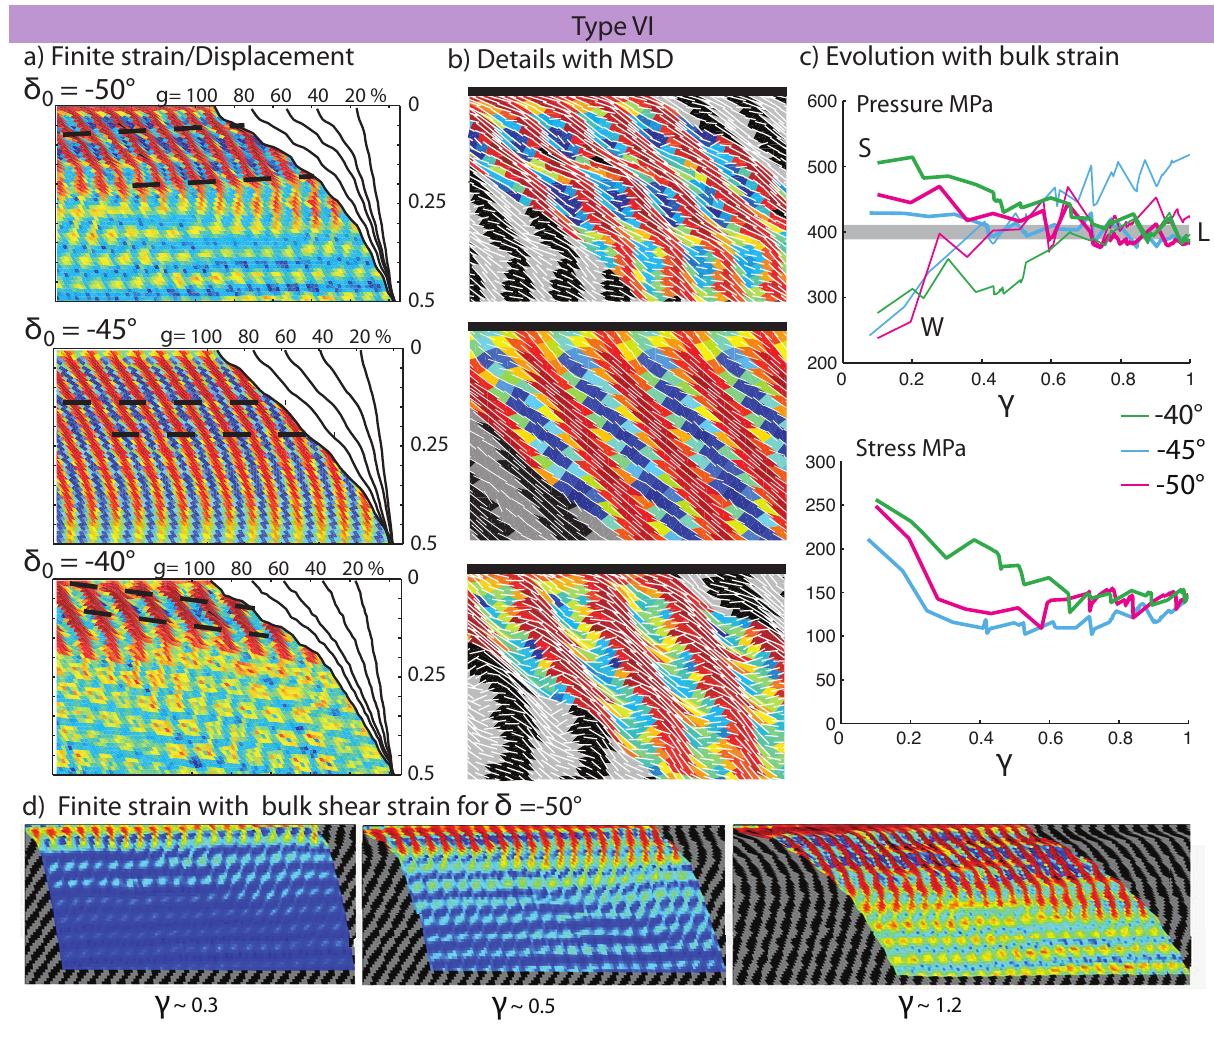
Fig. 7. Type IV (a) Maximum shear strain (red) is located in weak layers. Incipient shear bands orientation is outlined by dashed lines. Depth deformation profiles for γ respectively equal to 0.2, 0.4, 0.6, 0.8 and 1 show a progressive migration of the deformation towards depth and no localisation in the δ 0 = − 45 ◦ case. (b) MSD indicates that sliding along the weak layers predominates. (c) Pressure jump between strong (S) and weak (W) layers switches with bulk strain at values close to lithostatic pressure (L) and correponds to a dramatic drop of deviatoric stress in the strong layers. (d) for δ 0 = − 50 ◦ , shear bands propagate downwards as the layers get overturned and initial mullions turn into sheared asymmetric